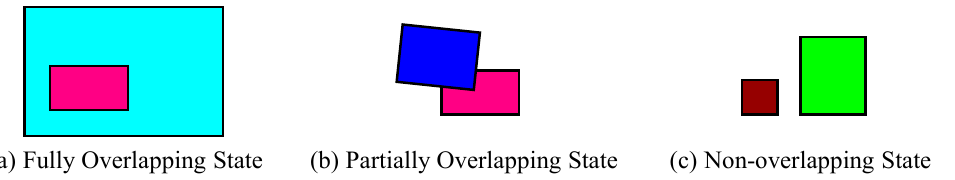
Figure 4. Sample DCNN input images.